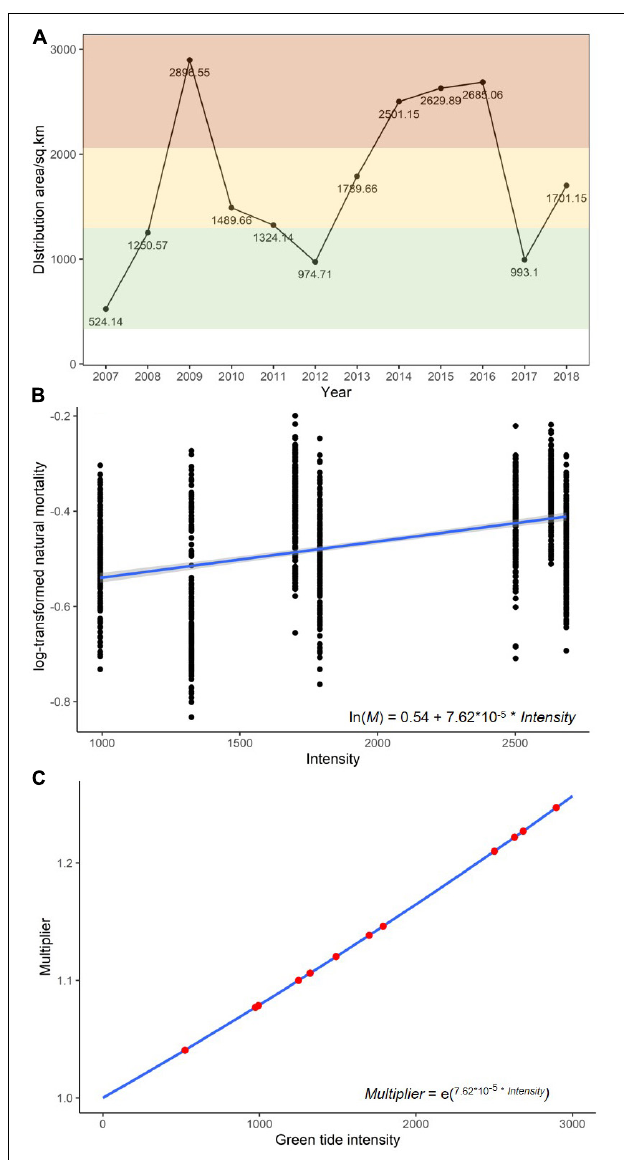
FIGURE 2 | (A) Historical green tide intensity measured with distribution areas, where the intensities of the 12 historical documents are categorized into high (red), medium (yellow), and low (green) levels. (B) The linear relationship fitted between the log-transformed natural mortality and the green tide bloom intensity. (C) The values of natural mortality multiplier under the historical bloom intensity (indicated with the red dots).